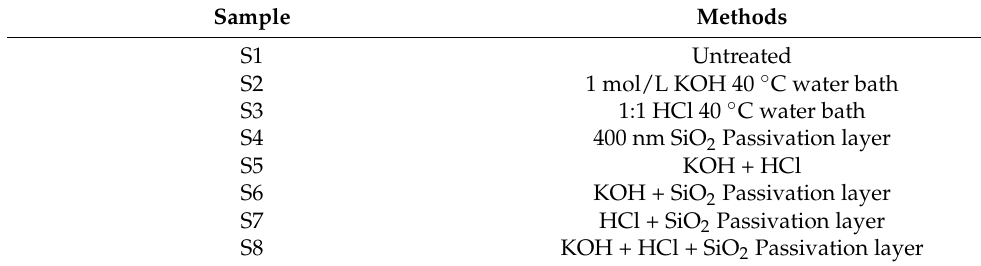
Table 1. Treatment of